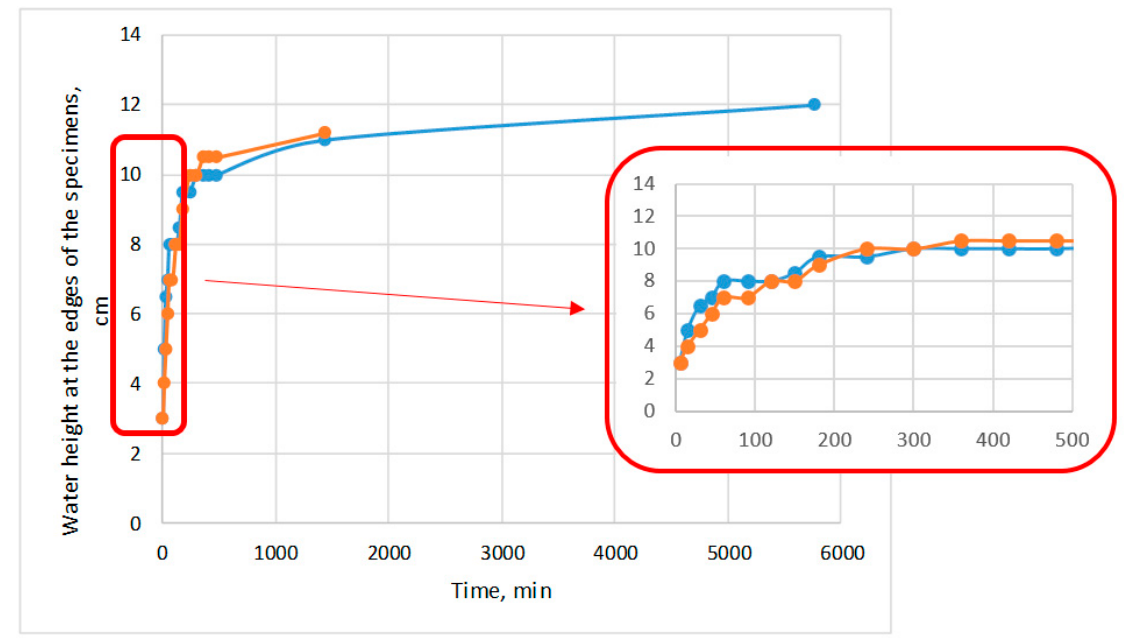
Figure 5. Water height at the edges of the specimens soaked 24 h ( ) and 96 h ( ), in cm.